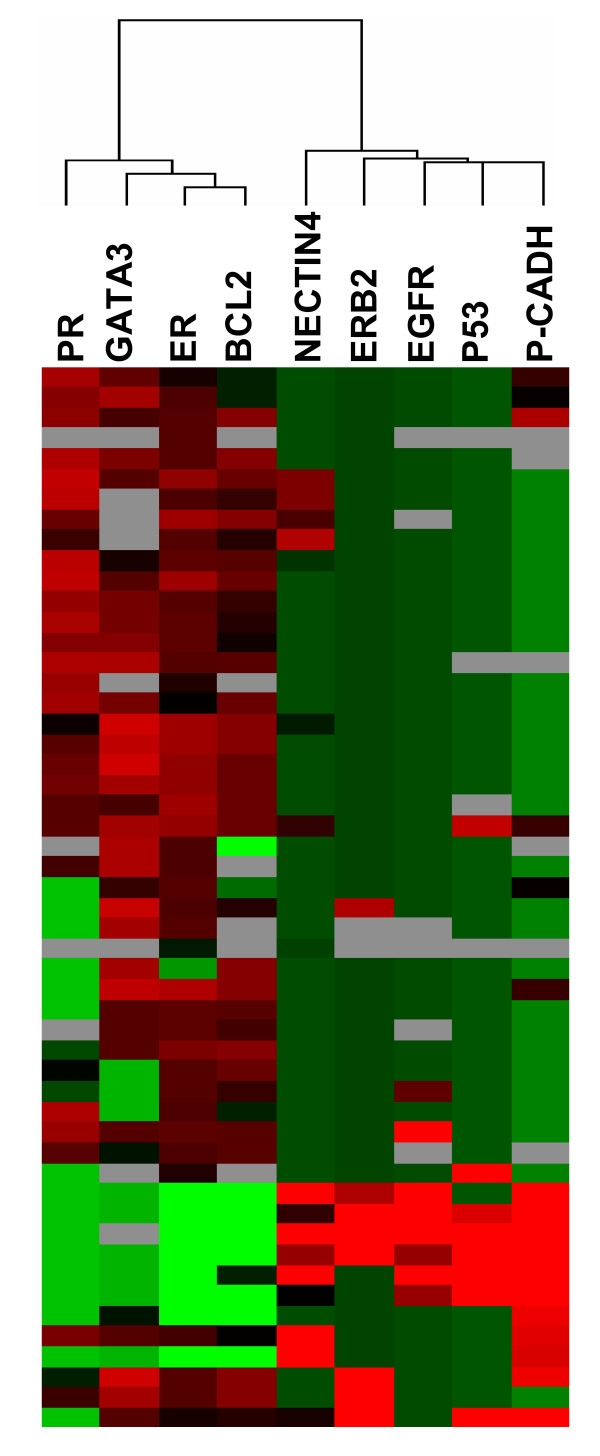
Nectin-4 expression correlates with basal-like breast markers. Graphical representation of hierarchical clustering results based on expression profiles of 9 proteins in 52 early breast cancer samples measured by immunohistochemistry. Rows: proteins; columns: samples. Protein expression scores are depicted according to a color scale: red, positive staining; green, negative staining; grey, missing data. Dendrograms represent overall similarities in protein expression profiles. Two clusters of proteins are described. A group of proteins, including Nectin-4, which present high expression profile similarities with basal breast markers. A group of proteins, including luminal markers, which negatively correlate with Nectin-4 expression and basal-like markers.